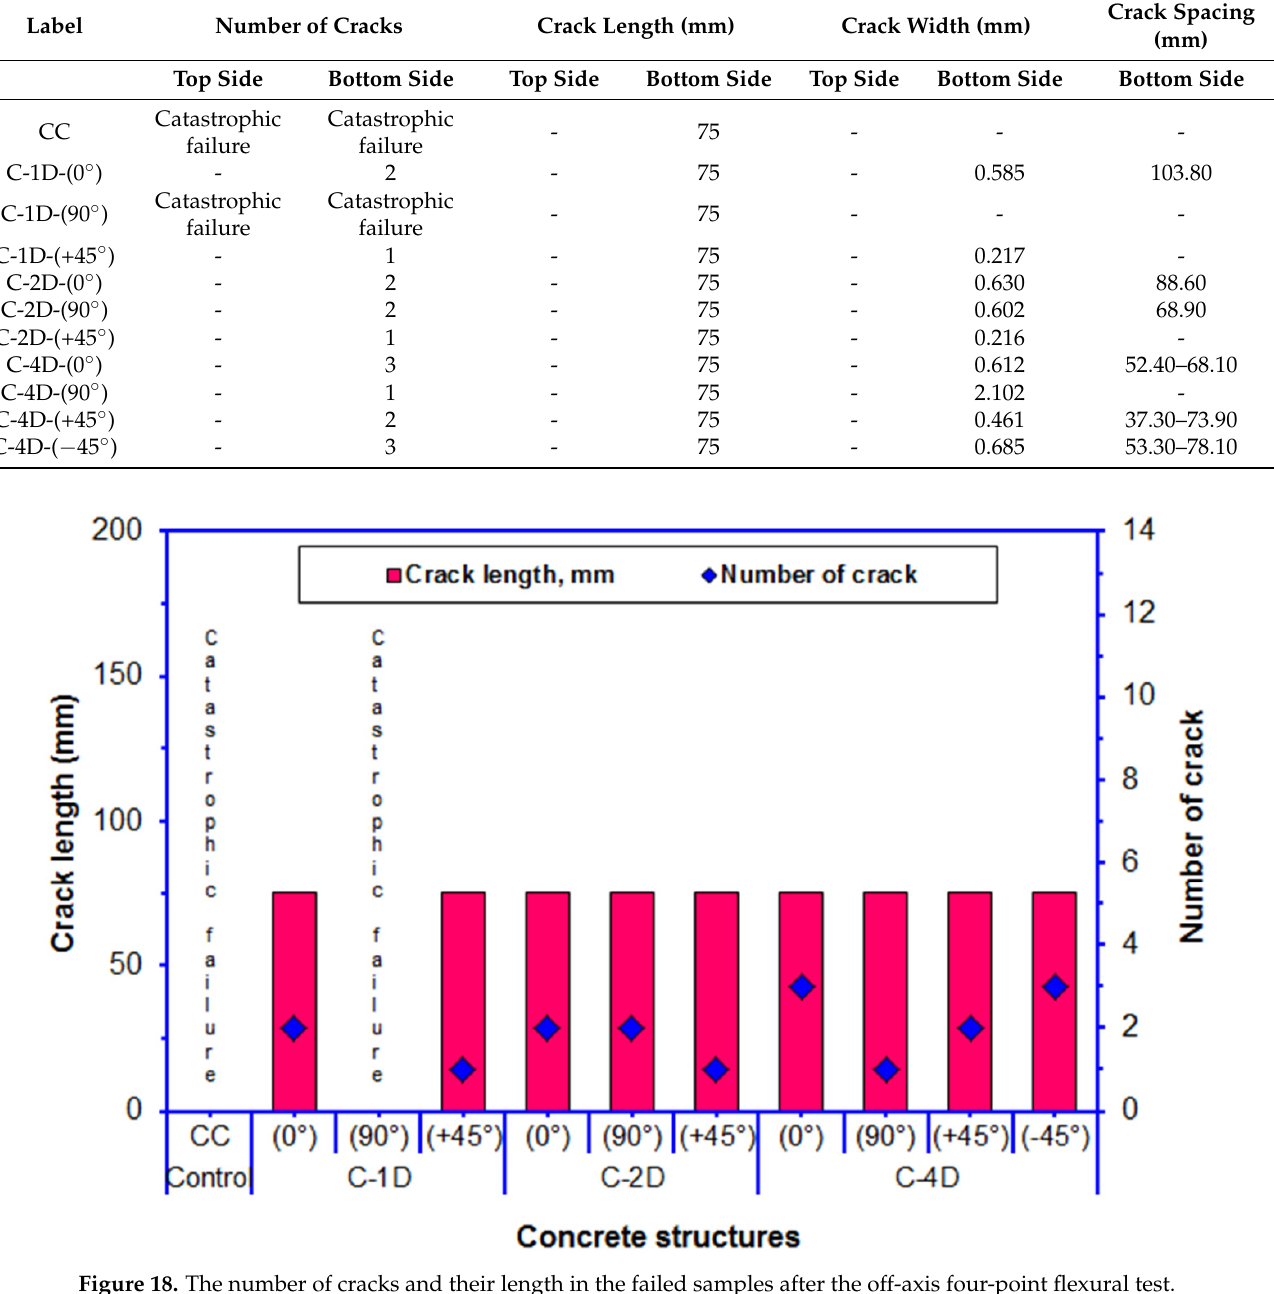
Figure 19. The number of Cracks and their width in the failed samples after the off-axis four-point flexural test. Various fractured multiaxis 3D carbon fiber concretes including C-1D-(0°, 90° and +45°), C-2D-(0°, 90°, and +45°), and C-4D-(0°, 90°, +45°, and − 45°), as well as the neat con- cretes on the top, bottom, and cross-sections and their failure modes after the off-axis